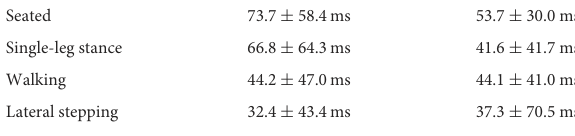
TABLE 3 Means and standard deviations for conflict effect flanker variable for all motor conditions before and after